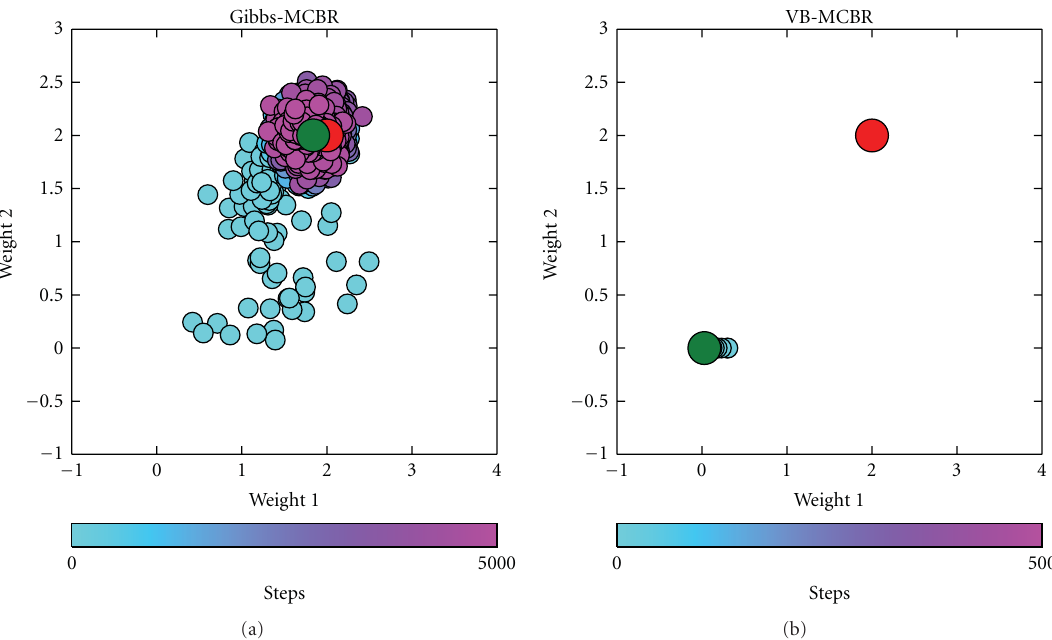
Figure 3: Results on simulated regression data. Weights of the first two features found for the di ff erent steps of Gibbs-MCBR (a) and VB- MCBR (b). The red dot represents the ground truth of both weights, and the green dot represents the final state found by the two algorithms. VB-MCBR is stuck in a local maximum, and Gibbs-MCBR finds the correct weights.